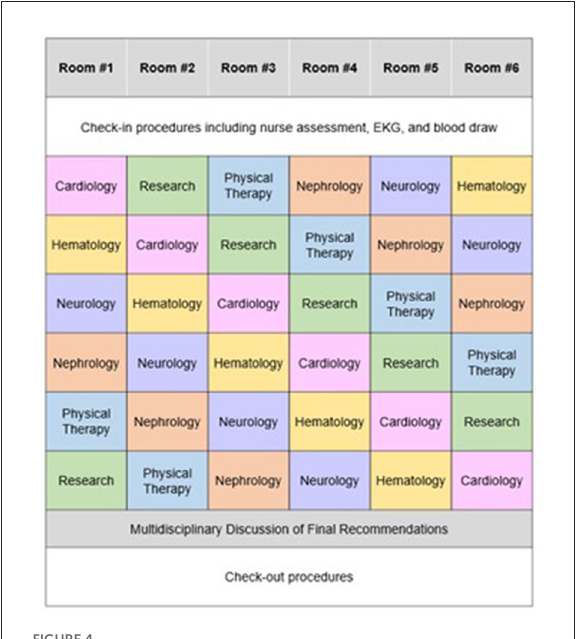
FIGURE4 Example schedule for a patient during a visit to the Ohio State University Comprehensive Amyloidosis Clinic.